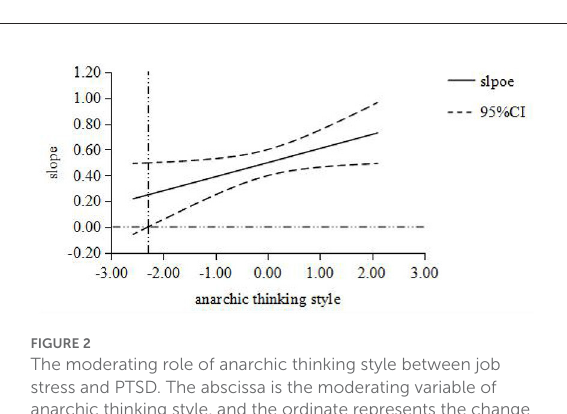
FIGURE1 The moderating role of monarchic thinking style between job stress and PTSD. The abscissa is the moderating variable of monarchic thinking style, and the ordinate represents the change of regression coefficient (i.e. slope) in regression equation with PTSD as dependent variable, job stress as independent variable and monarchic thinking style as moderating variable. All variables are standardized; The middle line is the point estimate, and the upper and lower lines are the values of 95% confidence interval.